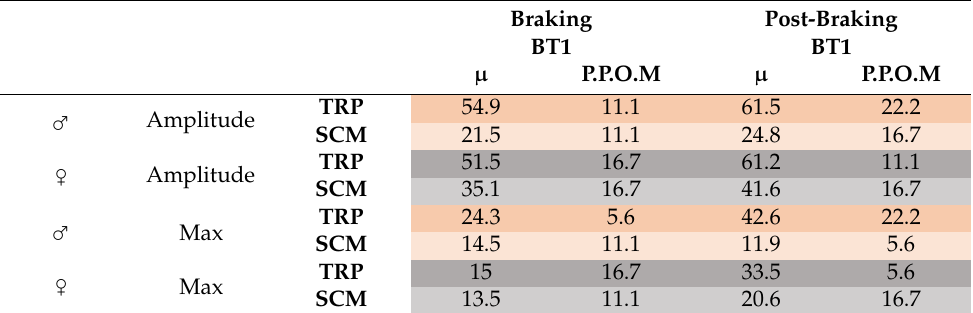
Table 4. sEMG parameters for BT1 (mean of the amplitude and maximum value reached) compute in the braking and post-braking phases (phase 2 and phase 3) sorted by genre ( Percentage of People Over the Mean; µ : mean value of the amplitude after normalisation (%).